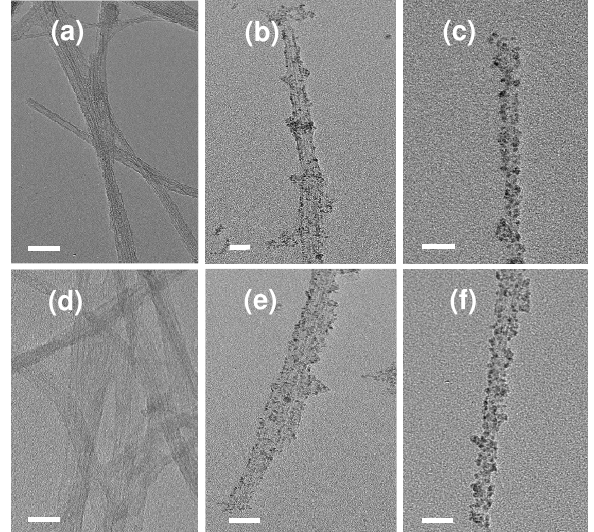
Figure 8. TEM images of oSWCNTs (a), pSWCNT/PdO (b), oSWCNT/PdO (c), oDWCNTs (d), pDWCNT/PdO (e), and oDWCNT/PdO (f). Scale bar: 20